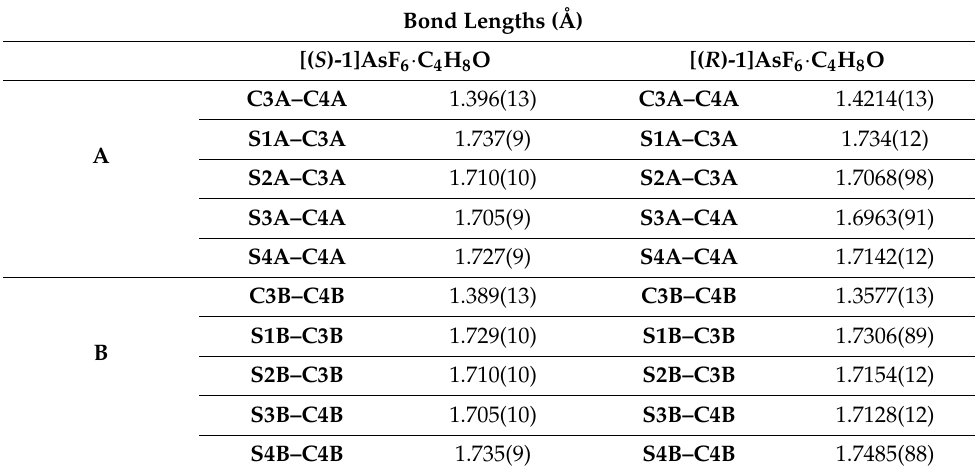
Table 2. Selected C = C and C–S internal bond distances for [( S )- 1 ] 2 AsF 6 and [( S )- 1 ] 2 AsF 6 .